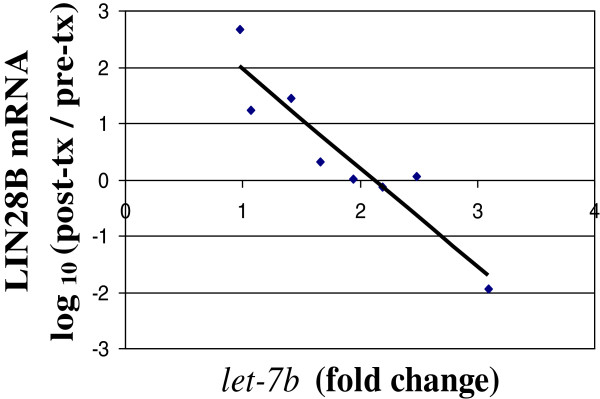
Inverse correlation between changes in miR-let-7b and proposed target LIN28B mRNA. miR-let-7b fold change (2^dLMR) with combination treatment is plotted against log10 of the percent change in LIN28B mRNA with combination treatment (post-treatment expression/pre-treatment expression) for each patient for whom both pre-treatment and post-combination treatment samples were available. The slope and intercept of the linear trendline were -1.75 and 3.7, respectively.